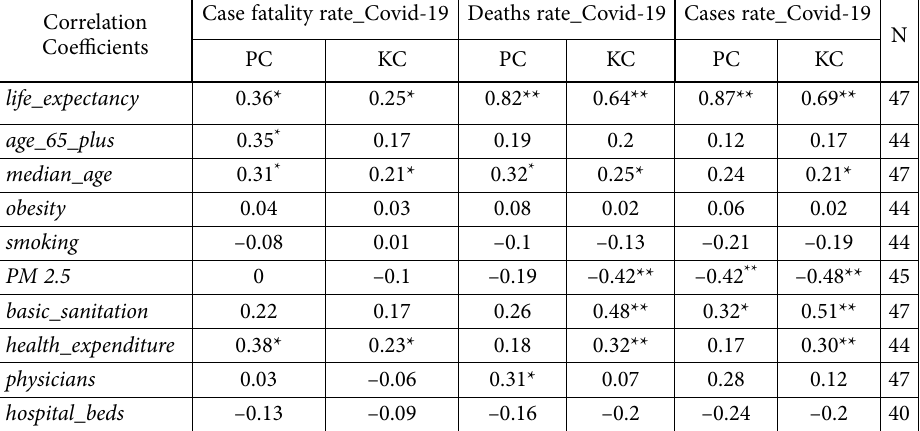
Table 1. Correlation analysis between population health-related indicators and Covid-19 indicators (source: authors’ computation using IBM SPSS Statistics 21) Correlation